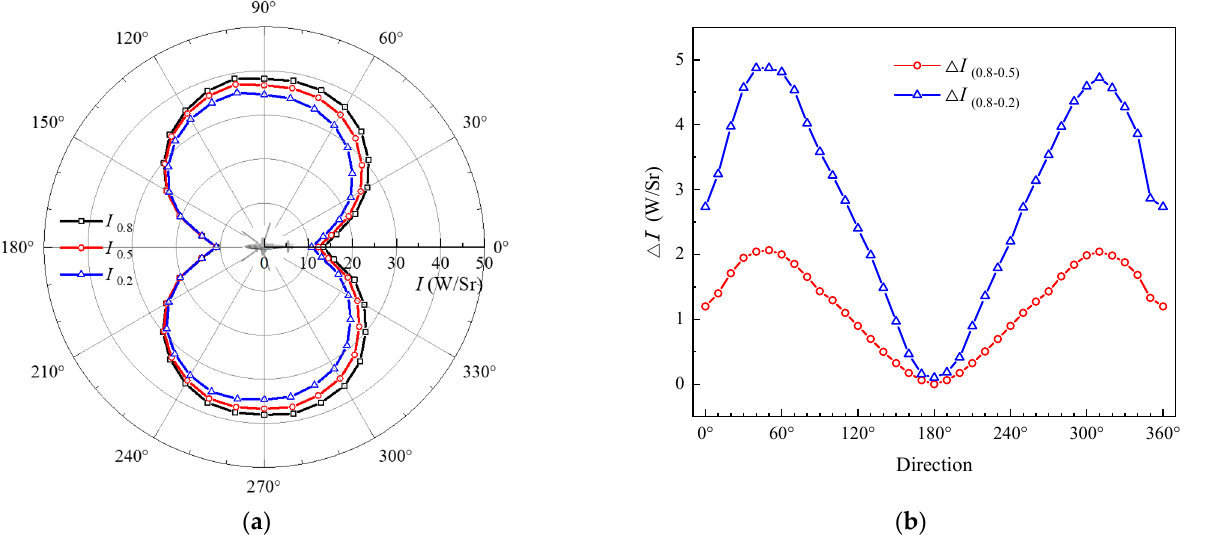
Figure 14. Infrared radiation intensity of helicopters with different rear fuselage surface emissivities in 3–5 µm band. ( a ) Infrared distribution characteristics; and ( b ) suppression value.